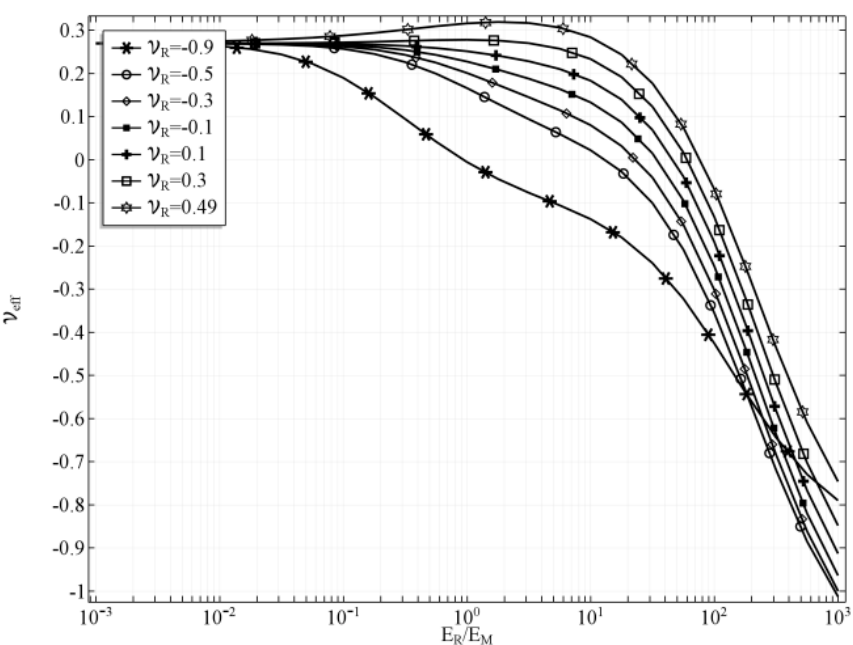
Figure 8. Effecive Poisson’s ratio with respect to E R /E M ratio for selected values of ν R , t h = 0.2.